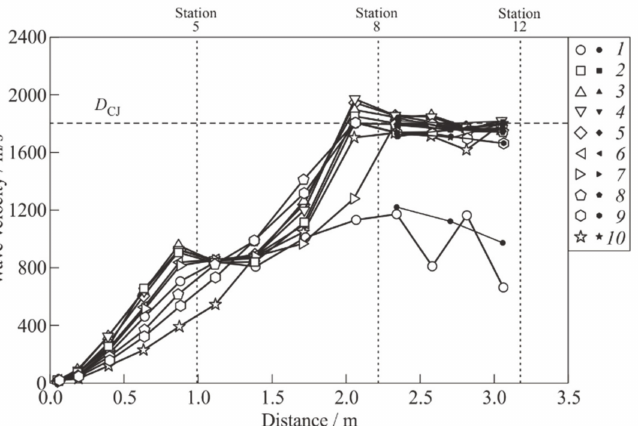
Figure 8. The measured dependences of the SW (filled symbols) and flame front (empty symbols) velocities on the distance traveled from the ignition source in each PDT shot in the experiment of Figure 6 ( T p = 765 ◦ C and m 0 = 10 g); the horizontal dashed line corresponds to the typical value of the detonation velocity D CJ in stoichiometric mixtures of hydrocarbon fuels: 1–shot 2; 2–3; 3–4; 4–5; 5–7; 6–8; 7–9; 8–10; 9–11; and